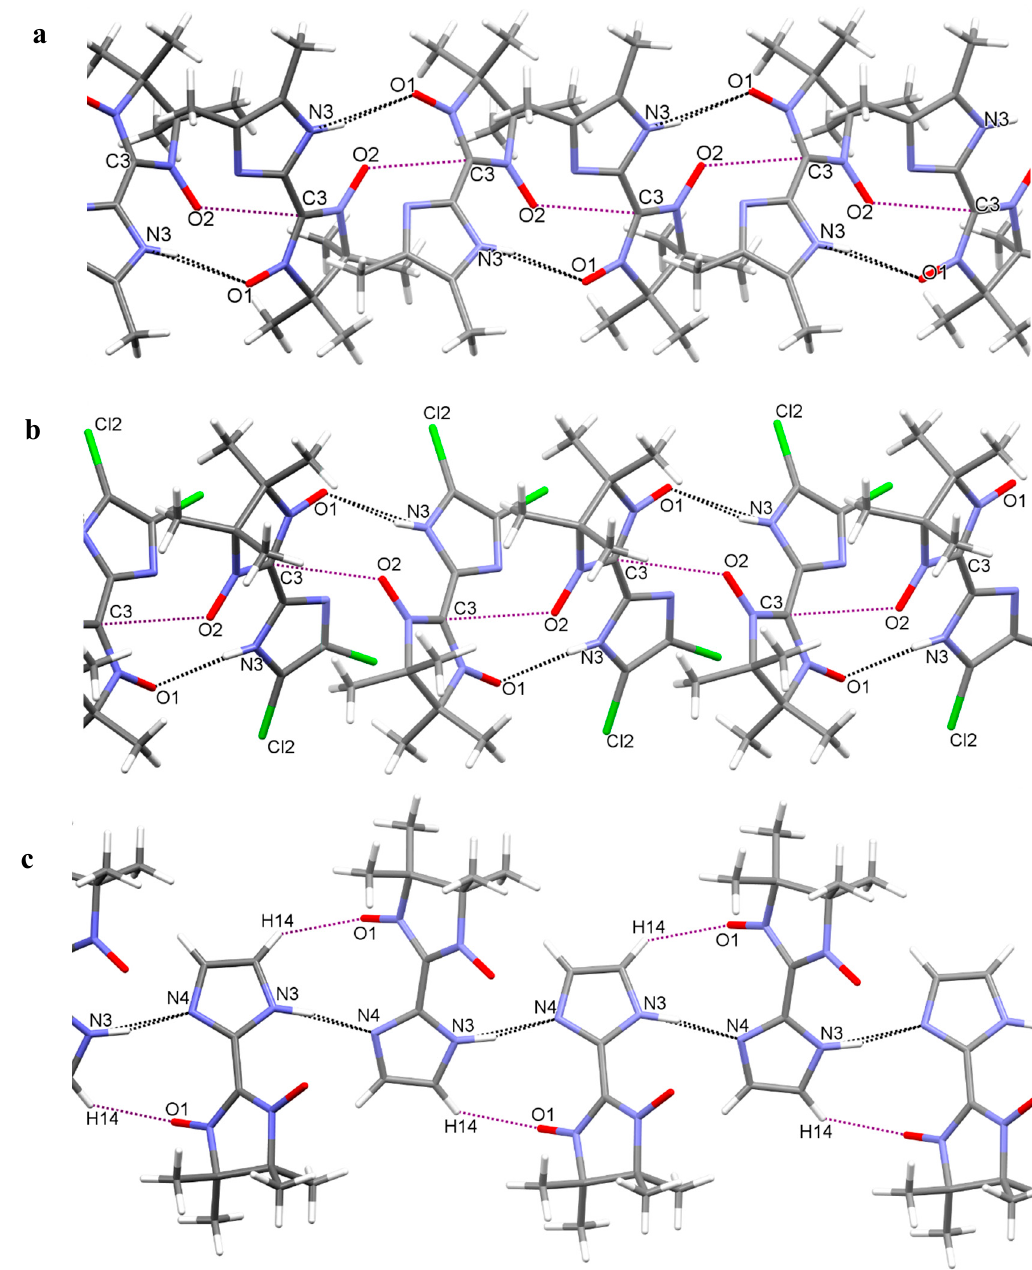
Figure 2. Fragments of the H-bonded chains in 1a ( a ), 1b ( b ), and 1c ( c ). Short contacts O2…C3 and O1…H14 are indicated by purple dotted lines.